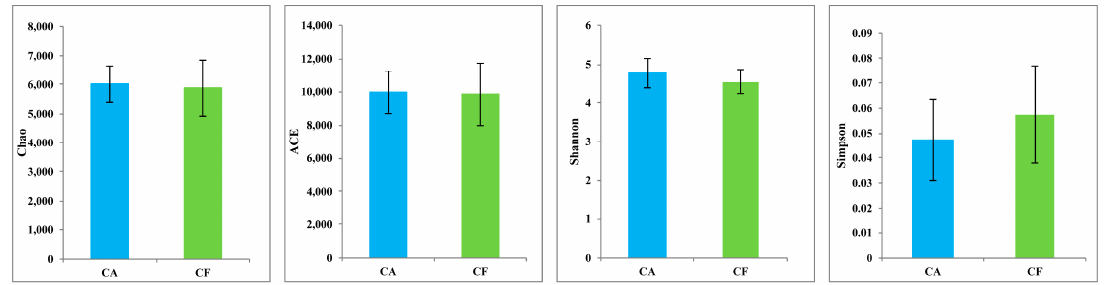
Figure 1. Phylogenetic diversity (mean ± SD) of the salivary microbiomes of the caries-affected (CA) and caries-free (CF) children.